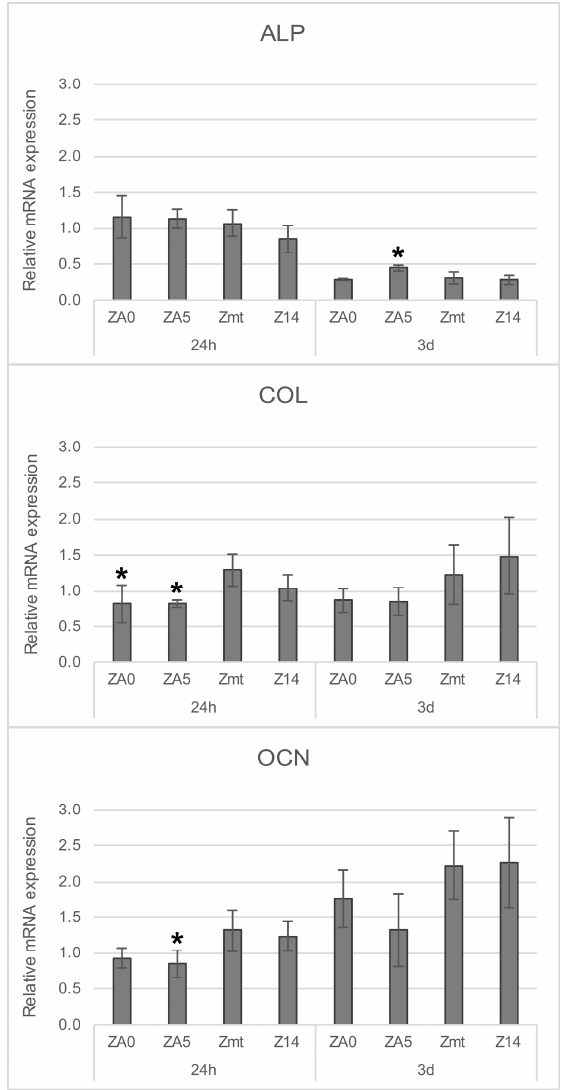
Figure 5. Relative mRNA expression of alkaline phosphatase (ALP), collagen type 1 (COL) and osteocalcin (OCN) in MG-63 cells on zirconia surfaces ZA0, ZA5, Zmt and Z14. The relative mRNA expression is normalized to the control cells grown on well bottoms after 24 h (=1.0), statistically significant differences in Zmt after 24 h or 3 d, respectively, determined with Student’s t-test, are indicated with * ( p < 0.05).